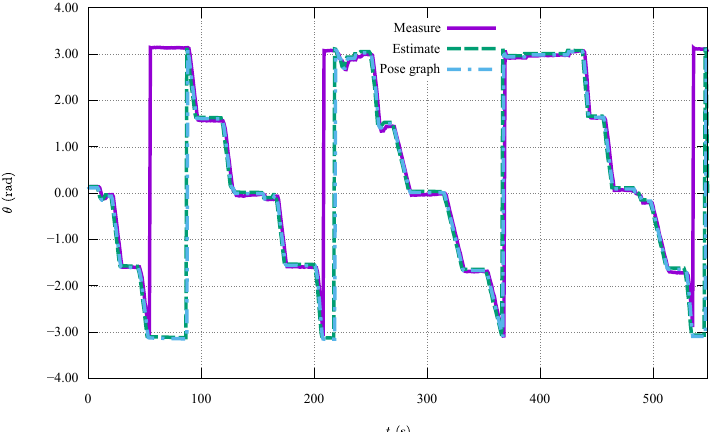
Figure 14. Heading angle of the robot. The heading angle of the robot is hardly affected by the loop